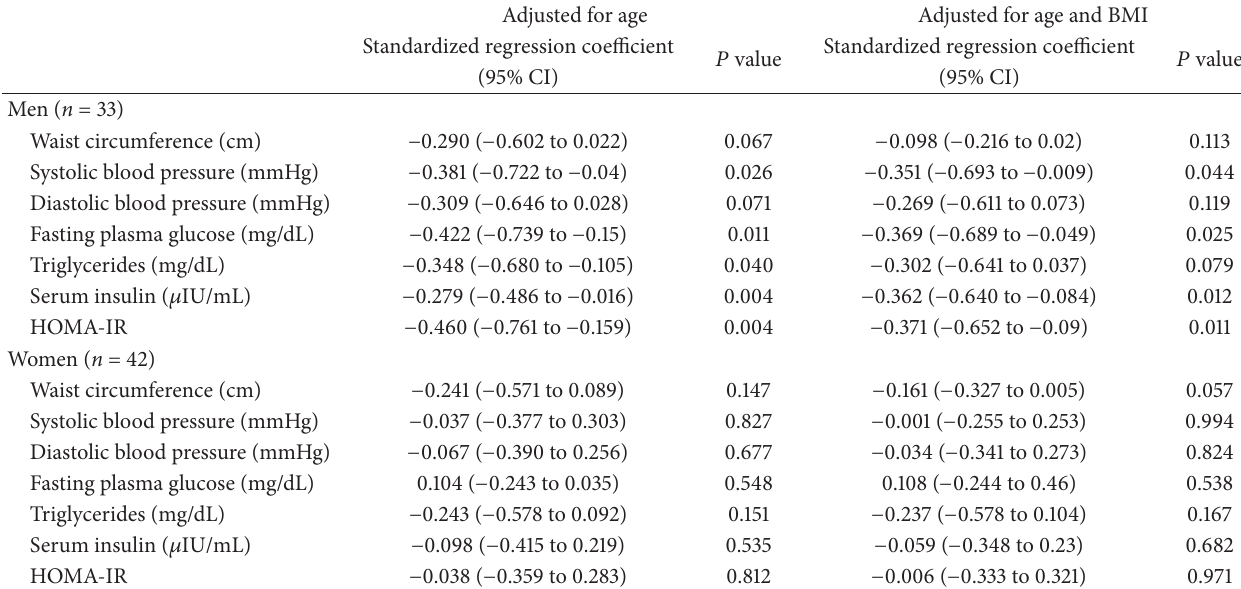
Table 3: Standardized regression coefficients of physical activity levels with metabolic risk factors in men and women with prediabetes or type 2